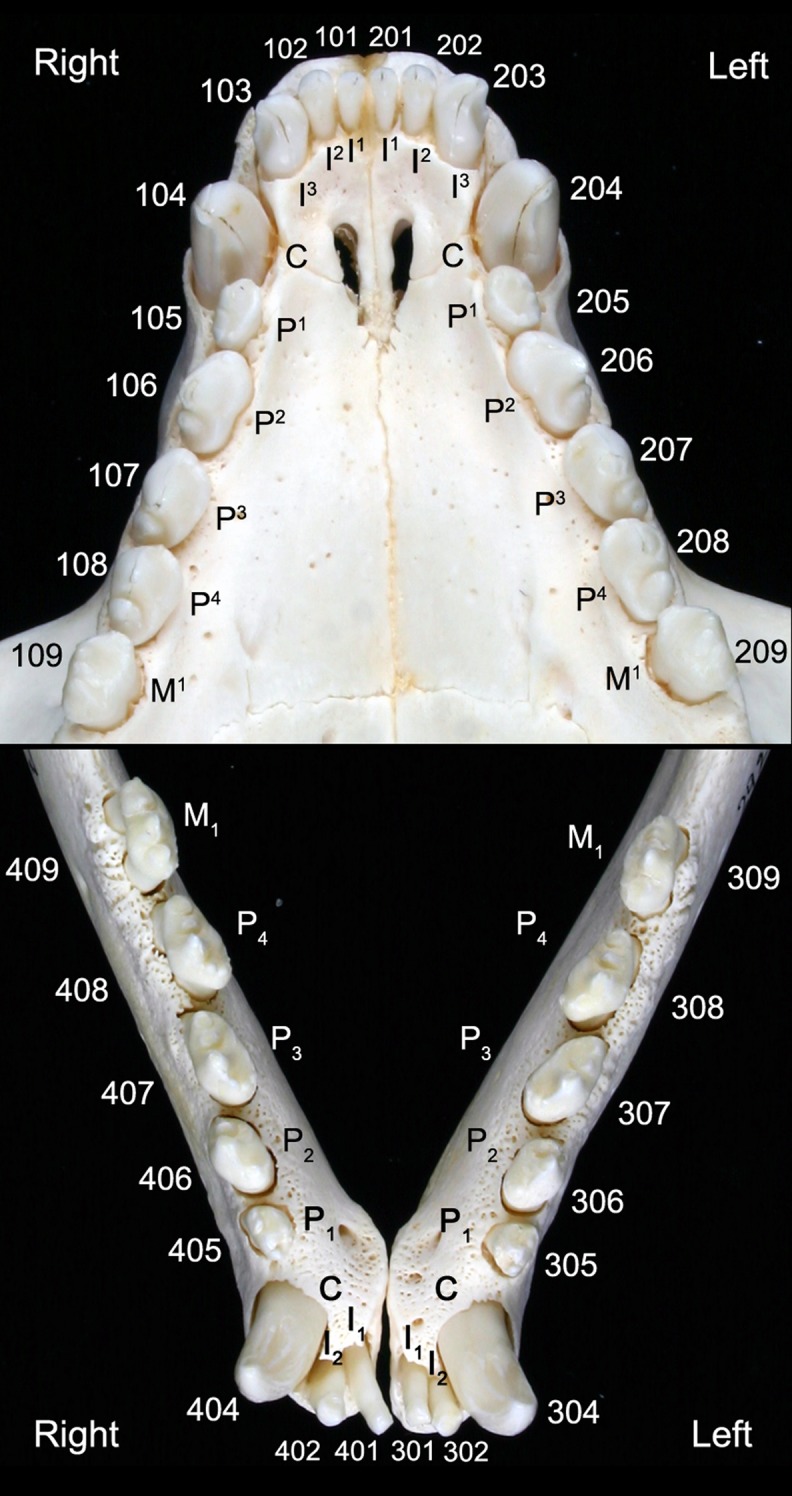
Permanent dentition of an Eastern Atlantic harbor seal (Phoca vitulina vitulina).The teeth in the maxillary (upper image) and mandibular (lower image) dental arcades are identified by anatomical terms and the numbering of the modified Triadan system frequently used in veterinary dentistry.